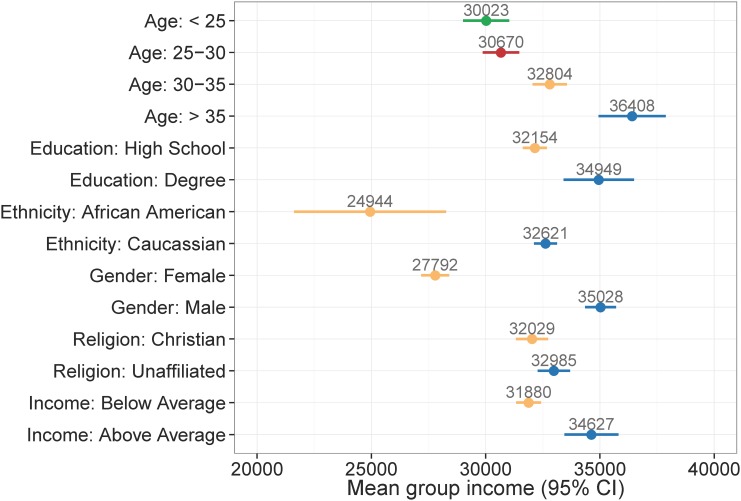
Mean income with confidence intervals for psycho-demographic groups.All group mean differences are statistically significant (Mann-Whitney test, p < .001).